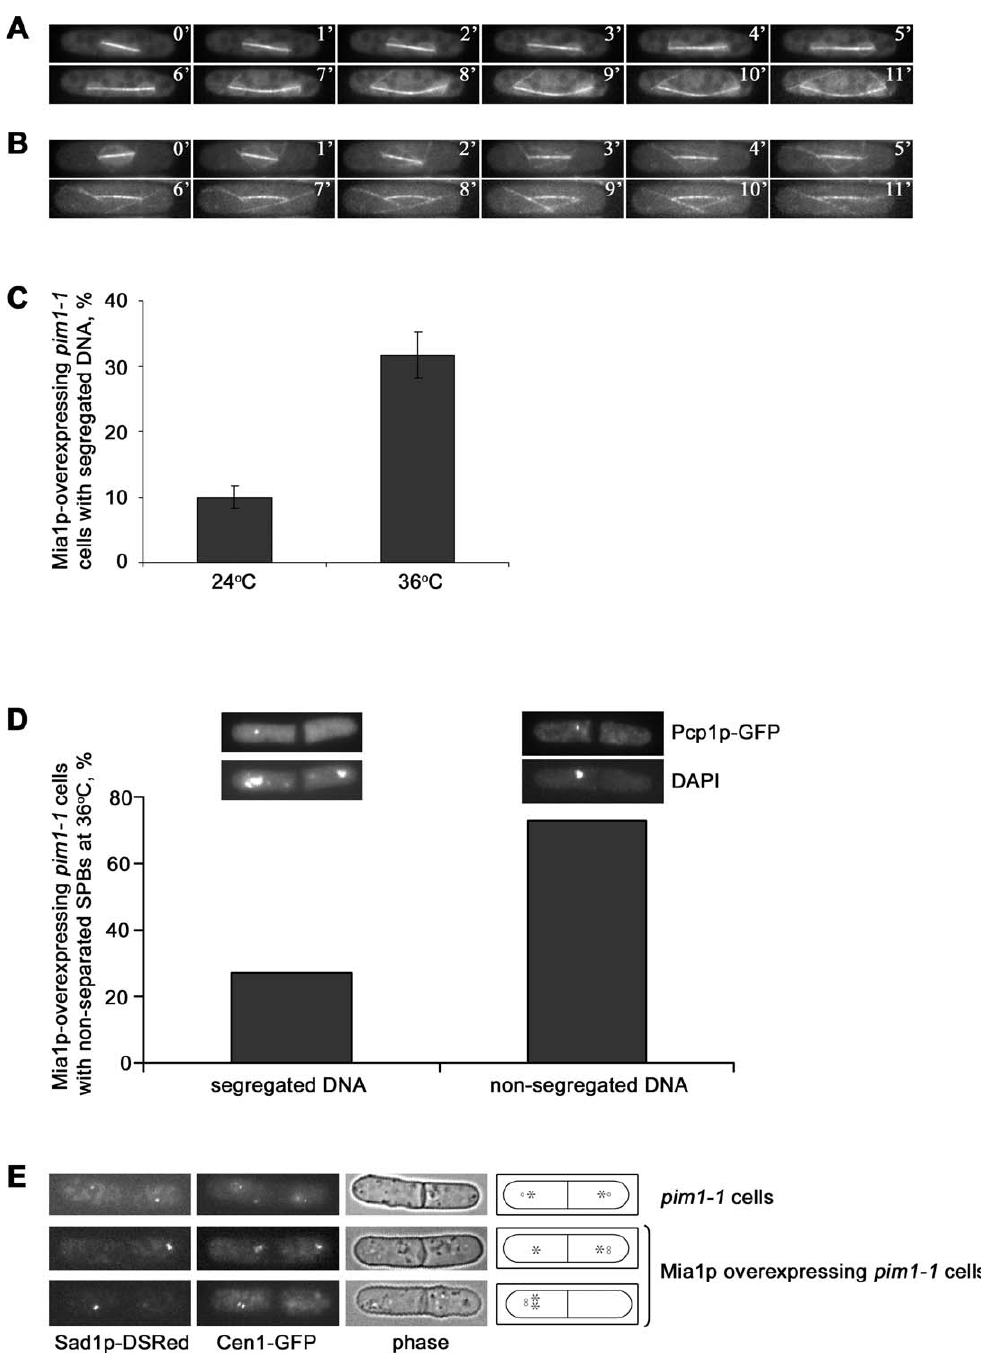
Figure 6. DNA Segregation Occurs in Mia1p-Overexpressing Cells When the NE Is Fragmented in Mitotic Cells Harboring the pim1–1 Mutation (A) Time-lapse sequence of an Uch2p-GFP a -tubulin-GFP–expressing pim1–1 cell undergoing anaphase at the permissive temperature of 24 8 C. (B) Time-lapse sequence of an Uch2p-GFP a -tubulin-GFP–expressing pim1–1 ts cell undergoing anaphase at the restrictive temperature of 36 8 C. Cells were shifted to the restrictive temperature 3 h prior to imaging to allow inactivation of Pim1p protein. Note that the NE is fragmented shortly after anaphase B onset. Shown are single maximum-intensity reconstructions of z -stacks. Numbers refer to the time, in minutes. (C) Graph quantifying the proportion of binucleate Pcp1p-GFP Uch2p-GFP pim1–1 cells overexpressing Mia1p at 24 8 C and 36 8 C ( n ¼ 300). (D) Graph quantifying the proportion of uninucleate and binucleate Mia1p-overexpressing Pcp1p-GFP Uch2p-GFP pim1–1 cells that do not separate the SPBs at 36 8 C ( n ¼ 100). Insets, examples of the scored phenotypes. Epifluorescence images of fixed Mia1p-overexpressing pim1–1 cells containing the core SPB marker, Pcp1p-GFP, and the outer NE marker, Uch2p-GFP, at 36 8 C. DNA is stained with DAPI. The NE is fragmented. Shown are single maximum-intensity reconstructions of z -stacks. (E) Epifluorescence images of Cen1-GFP Sad1-DSRed–containing pim1–1 cells, with and without Mia1p overexpression. Shown are single maximum- intensity reconstructions of z -stacks. Cartoons outline the phenotypes scored. Circle indicates the SPB; star indicates the centromere I.